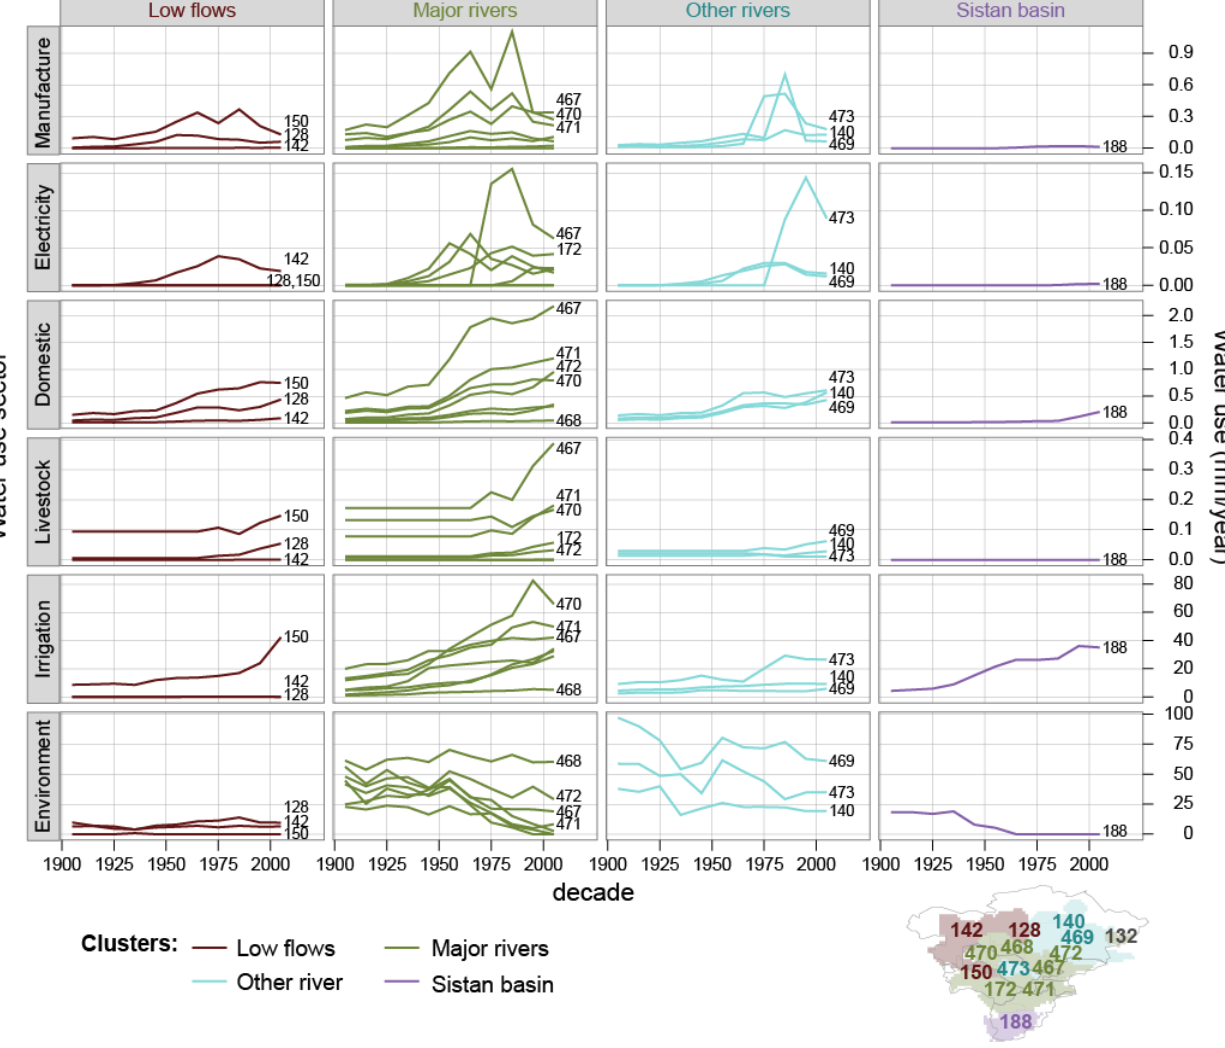
Figure 5. Temporal evolution of water uses for each food production unit (FPU). Each row represents a specific water use sector. Scales differ between